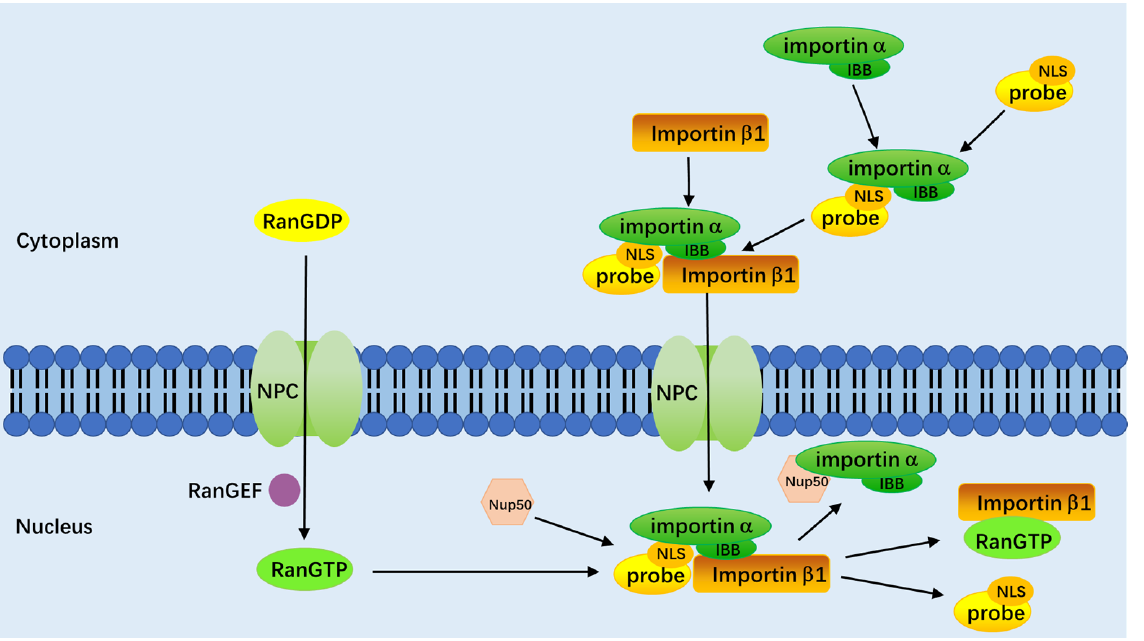
Figure 4. Schematic model of the nucleoplasmic transport of the NLS-probe.